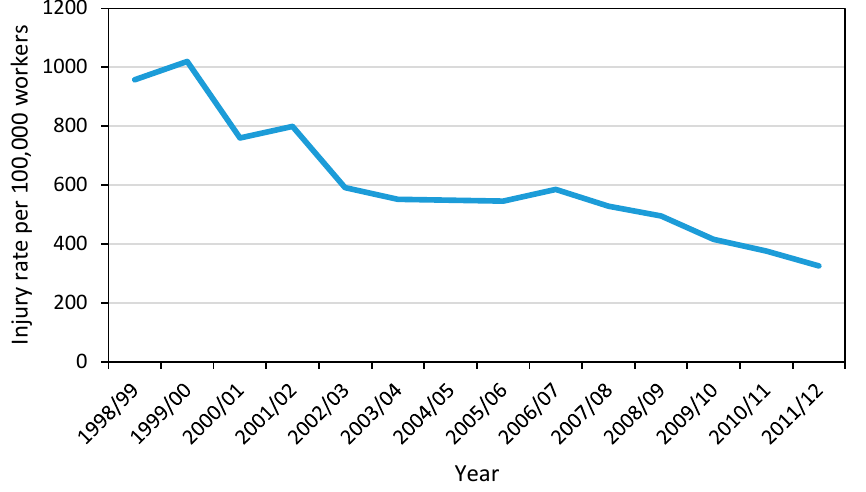
Figure 1. Oil and gas offshore injuries over 3 days from 1998–2012 [9].